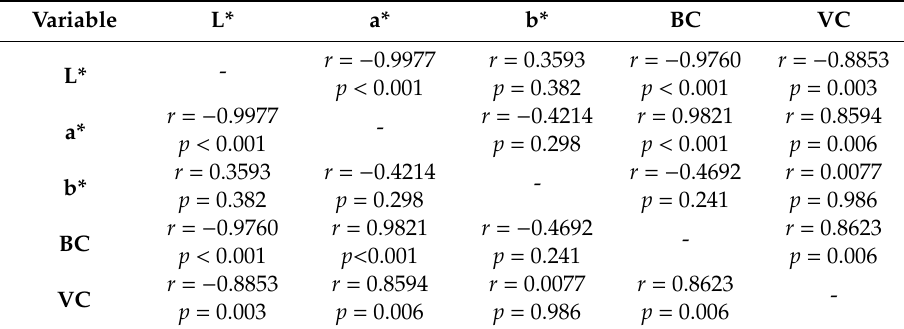
Table 4. The results of Pearson’s correlation analysis.